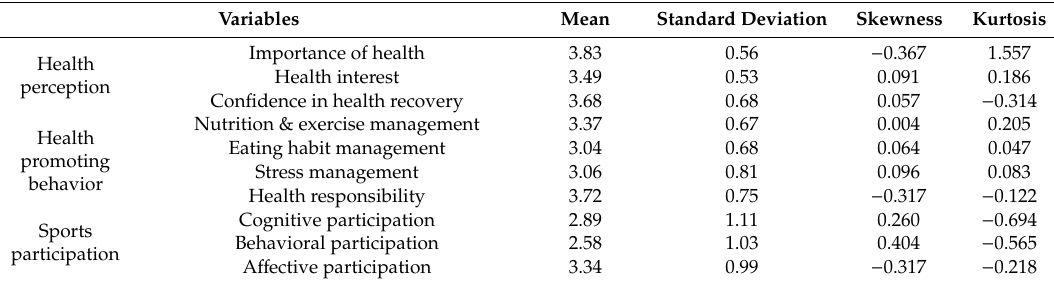
Table 6. Descriptive statistical analysis results.